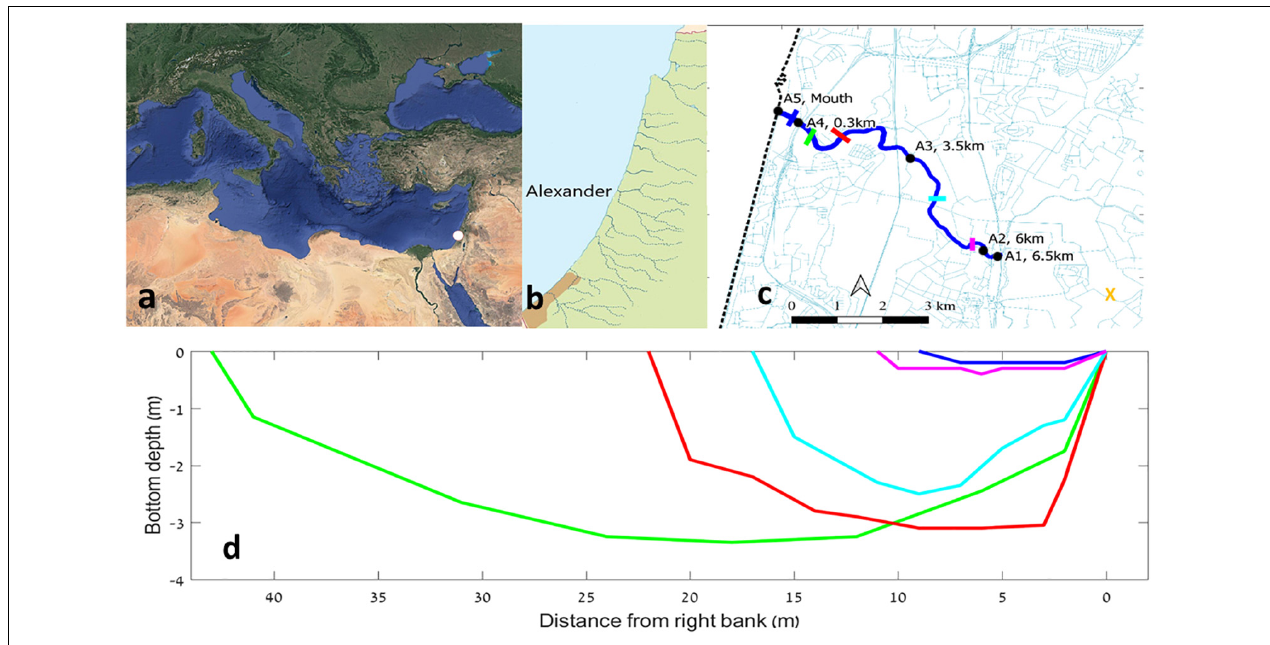
FIGURE 1 | The location of the Alexander estuary and its bathymetry. (a) The location of the estuary at the Mediterranean Levantine basin denoted by white dot. (b) Coastal streams along the Israeli coast. (c) A map of the estuary (in blue) and the location of the sampling points (black dots), bathymetry sampling cross sections (colored lines), and water inflow sampling station (orange “X” symbol). (d) Depth of bathymetric cross sections along the estuary. Each of the five series represent median bottom depth for a 300 m long